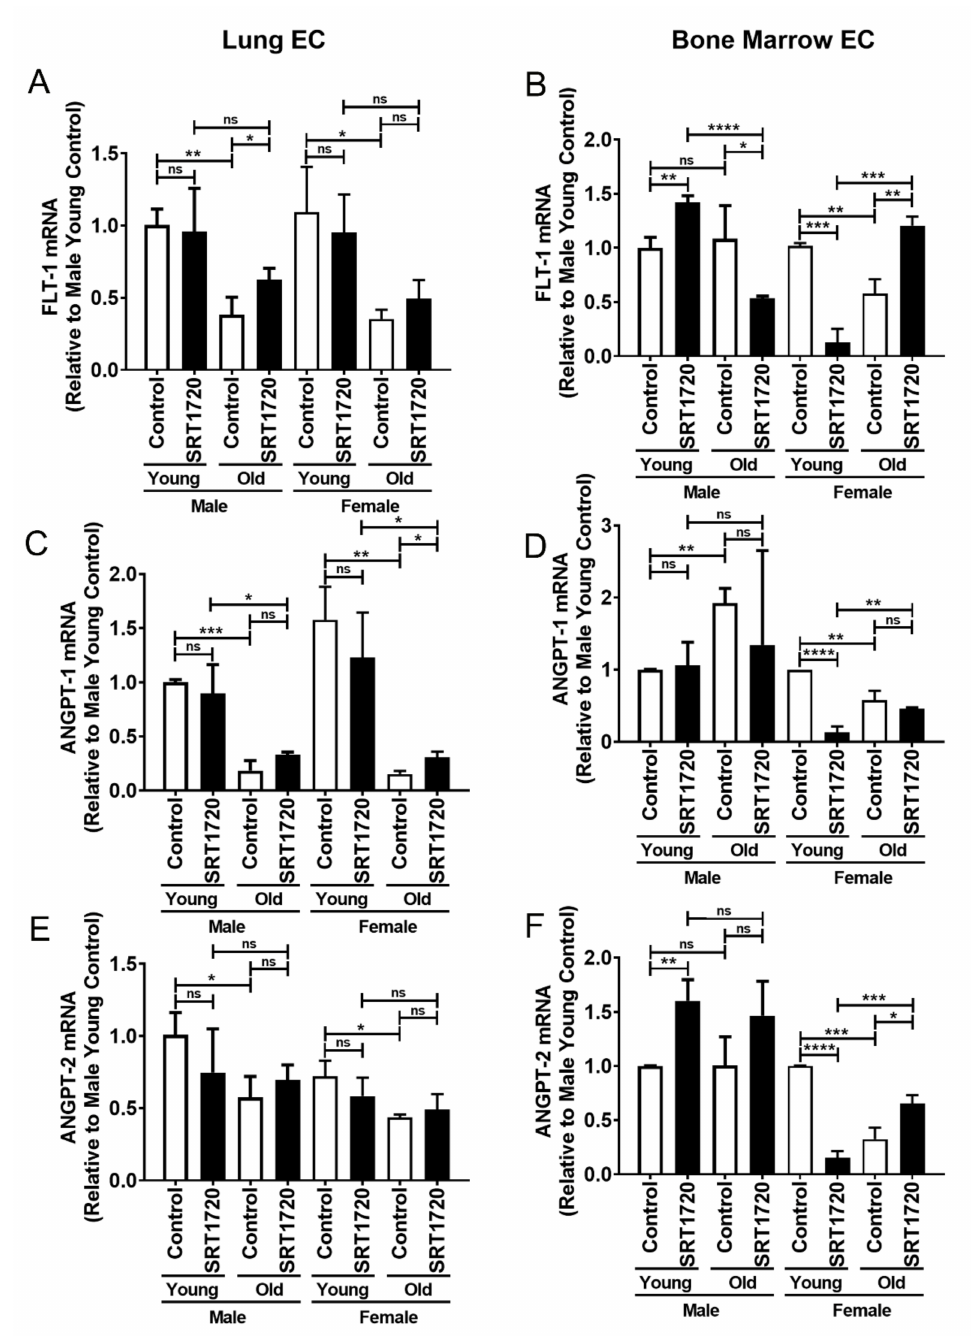
Figure 2. Real-time PCR analysis of ECs isolated from lungs ( A , C , E ) or bone marrow ( B , D , F ). Relative mRNA expression was measured for the following genes: fms-related tyrosine kinase-1 (FLT-1) ( A , B ), Angiopoietin 1 (ANGPT-1) ( C , D ), and Angiopoietin 2 (ANGPT-2) ( E , F ). Young male control (vehicle treated) expression was set to 1.0 and expression in all other samples are shown relative to the young male control. Data are expressed as the mean ± SD. An unpaired Student’s t -test was used to identify statistically significant differences. n = 3 mice/sex/age. ns = not significant, * p < 0.05, ** p < 0.01, *** p < 0.001, and **** p <